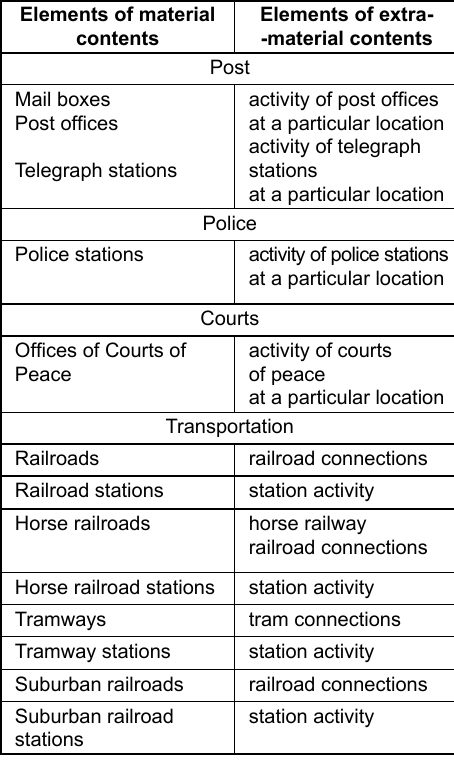
Table 2. Material and immaterial elements of